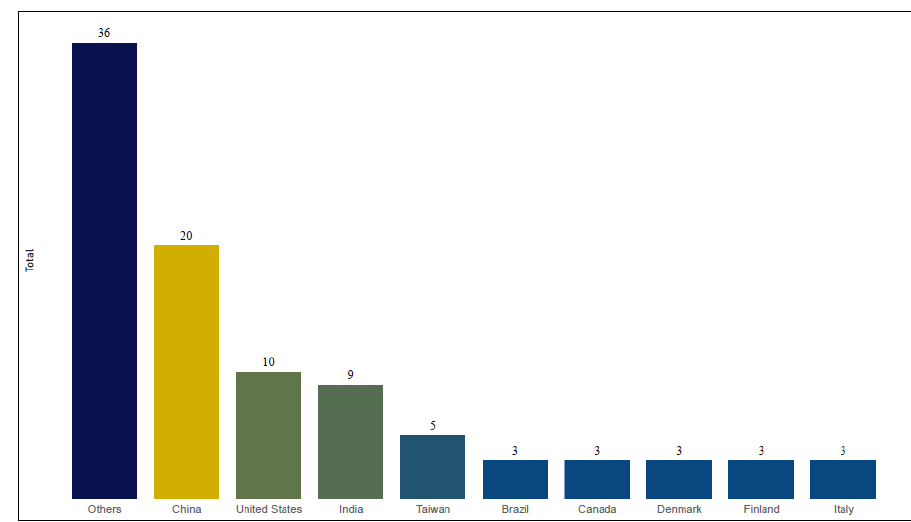
Figure 4. Publications separated by country.